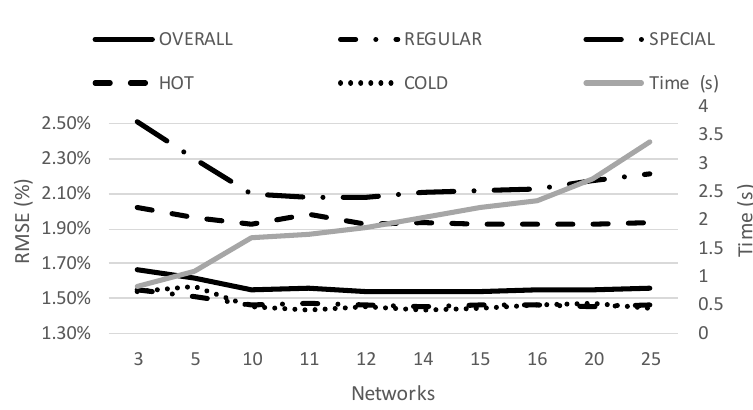
Figure 12. Overall forecasting error (RMSE) and execution time with different redundant networks.